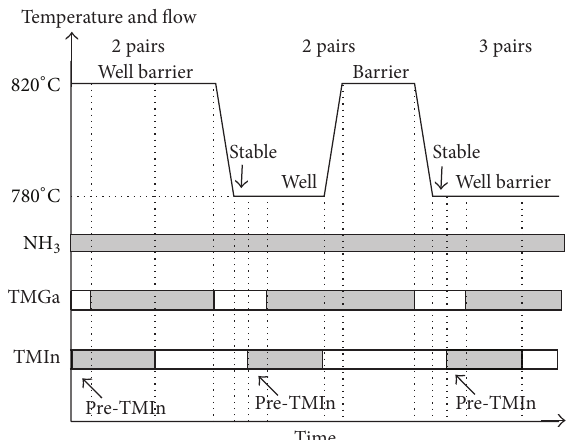
Figure 1: Growth conditions for pre-TMIn treatment in InGaN/ GaN MQW.